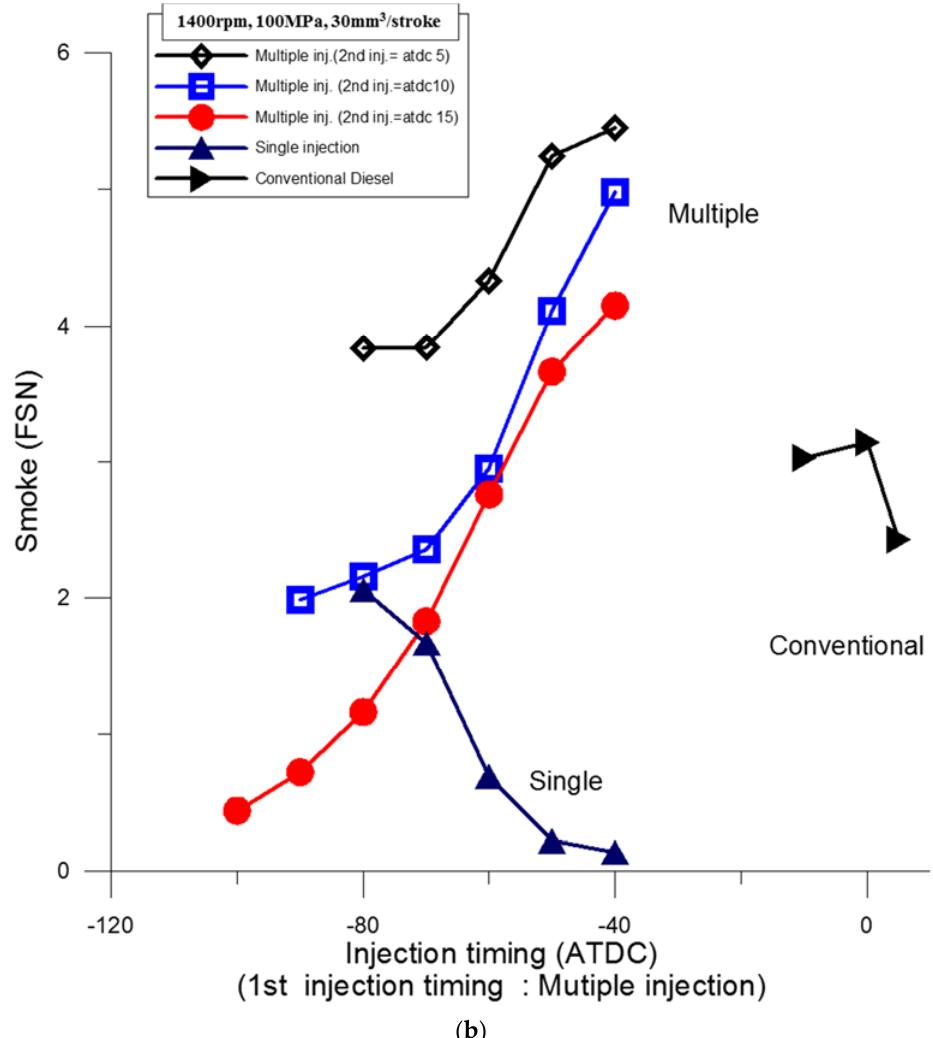
Figure 2. Emission performance of multiple injection diesel DI ‐ HCCI combustion (1400 rpm, 30 mm 3 /stroke). ( a ) NO x ; ( b ) Smoke.